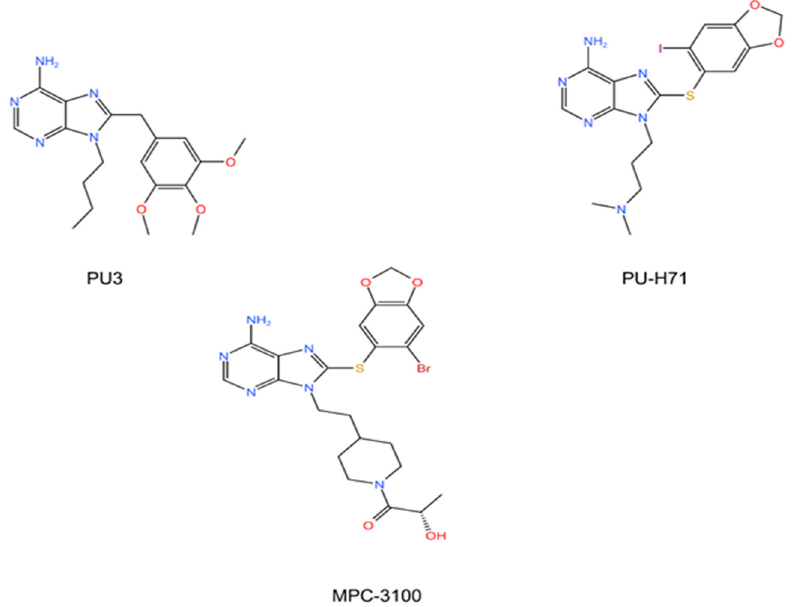
Figure 5. Purine and purine-like inhibitors of HSP90. PU3, PU-H71 and MPC-3100RD. Chemical structures are from http://www.chemspider.com (Accessed on 16 August 2022).